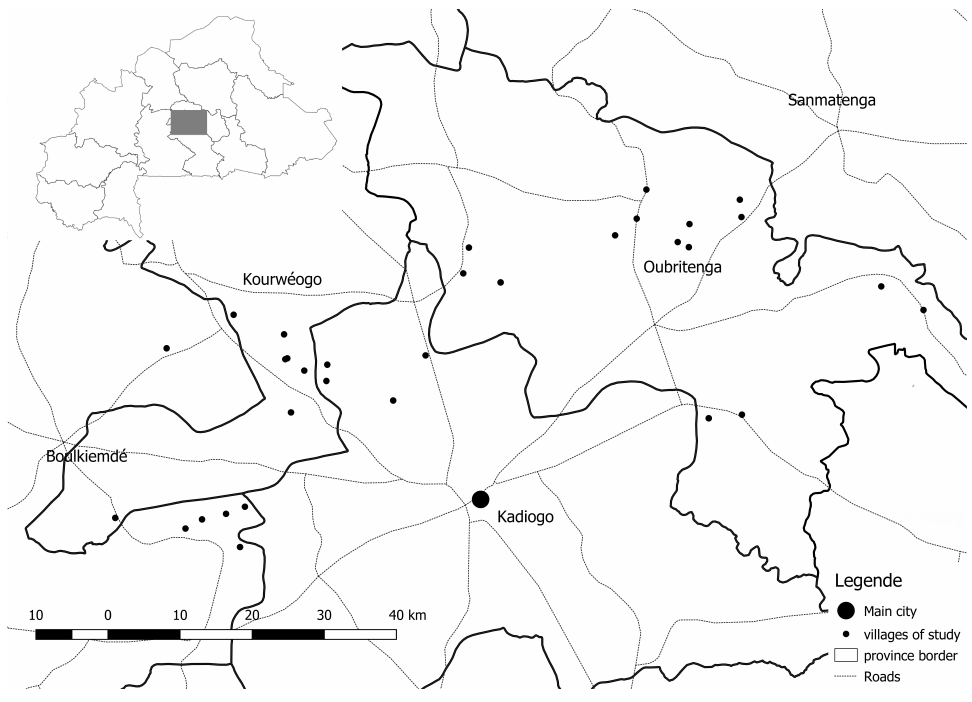
Figure 1. Map of the study